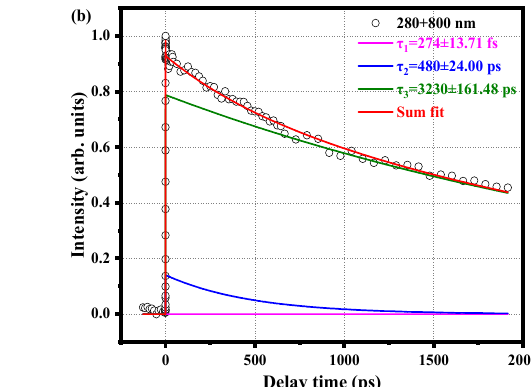
Figure 2. MO29, MO30, MO32 orbitals of o -fluoroaniline S 1 state. Calculation method and basis set: TD-DFT and CAM-B3LYP/6-311+G(d,p).